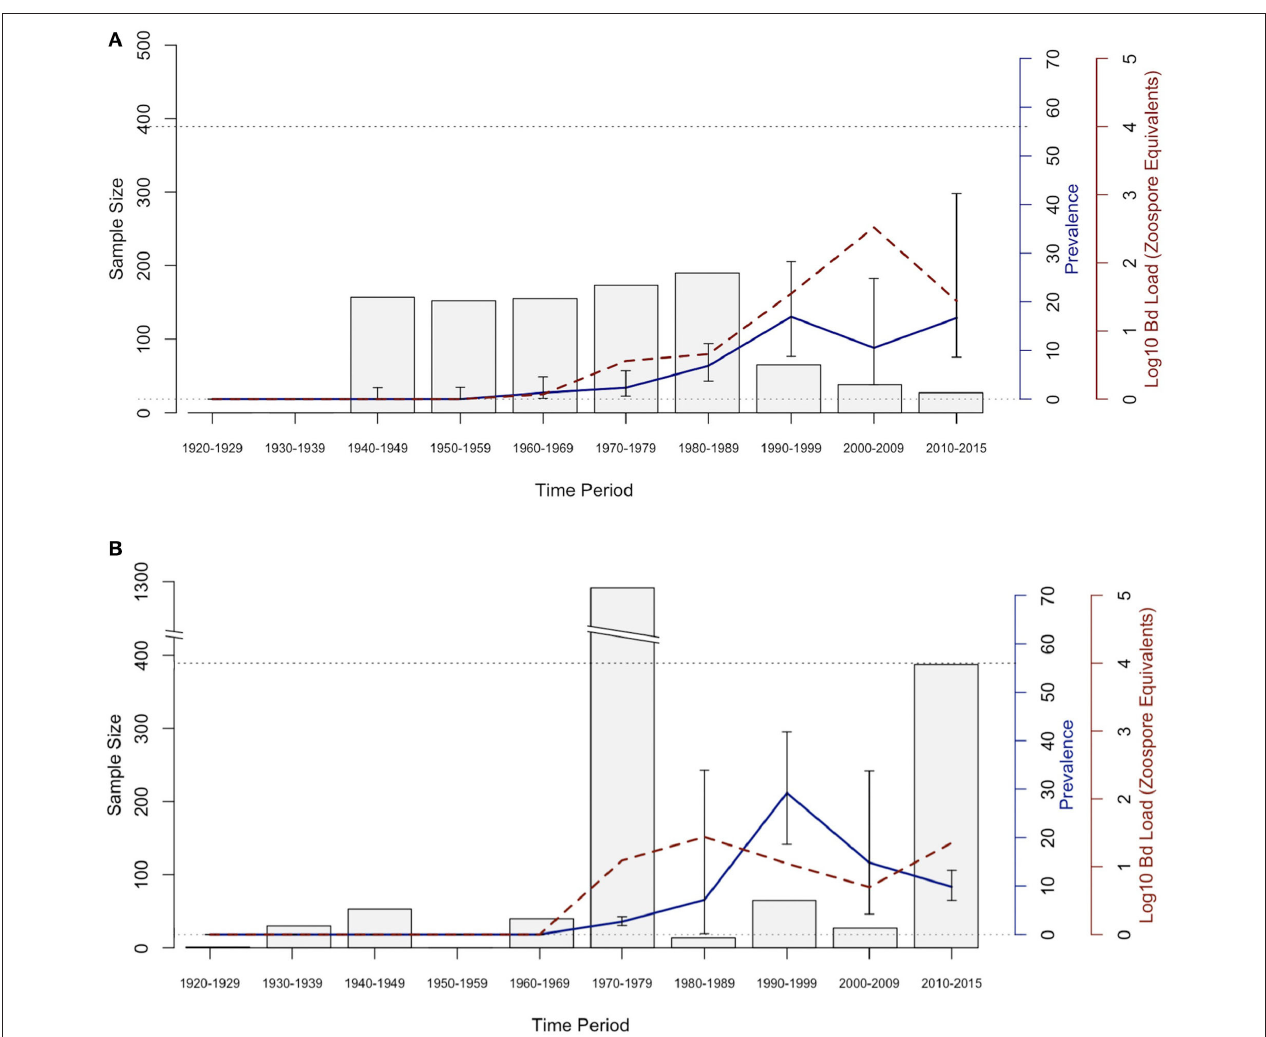
FIGURE 2 | Bd prevalence and infection intensity by decade in museum specimens of (A) Aneides lugubris and (B) Batrachoseps luciae . From left to right, 1st Y-axis and bars represents sample size, 2nd Y-axis axis and blue line graph represents Bd infection prevalence, and the 3rd Y-axis and dotted red line represents Bd infection intensity (Log10 zoospore equivalents). Error bars represent credible intervals of Bd infection prevalence based on a binomial distribution and a 0.11 expected Bd prevalence from an area where Bd is assumed to be endemic ( 21,